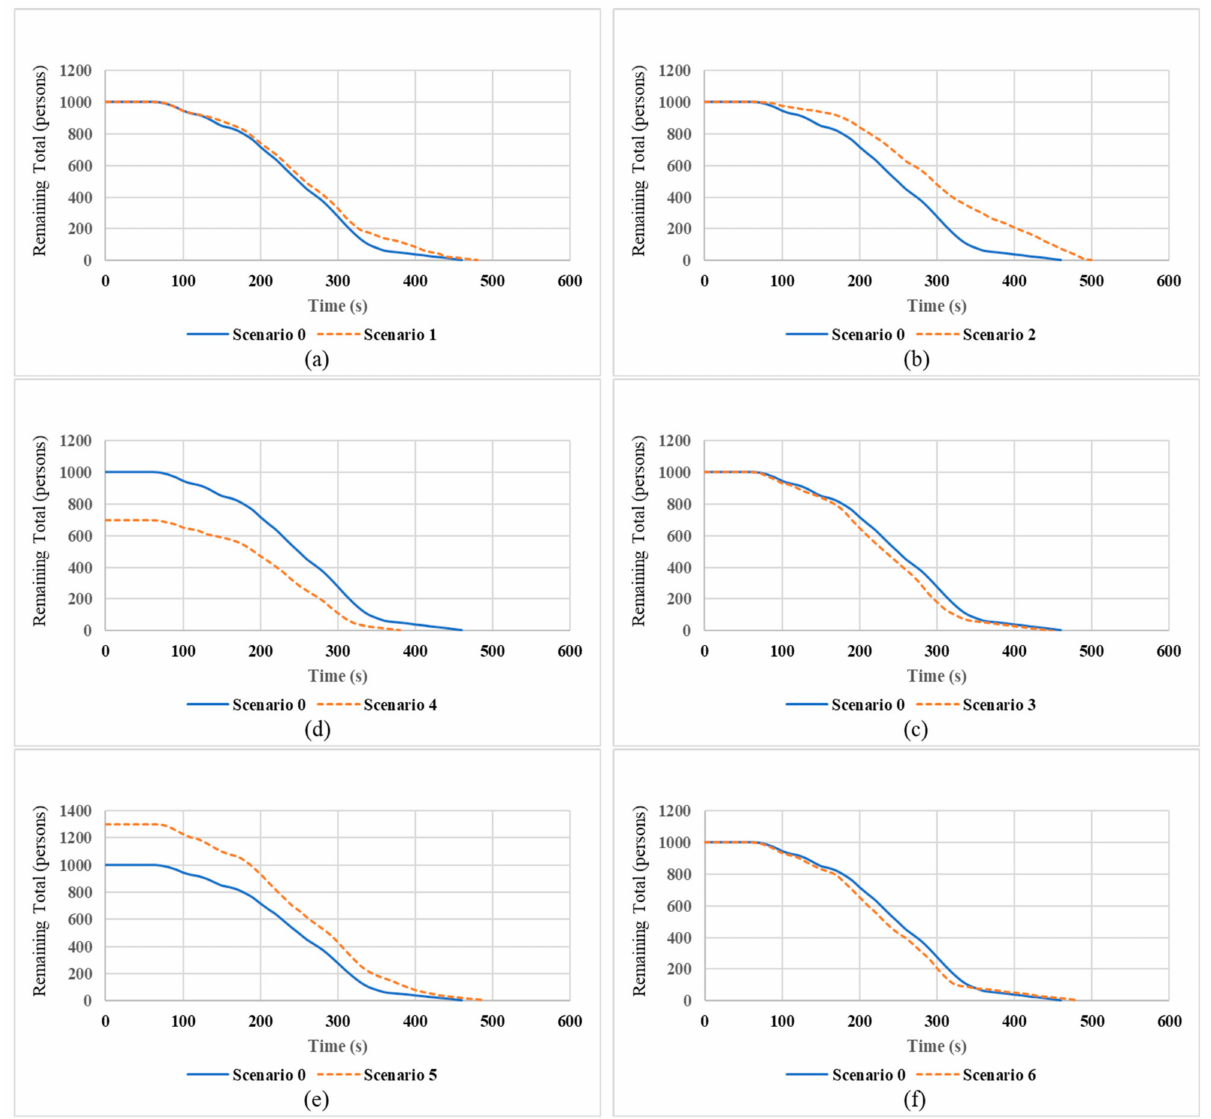
Figure 7. Remaining evacuees for experimental design. ( a ) scenario 0 vs. scenario 1; ( b ) scenario 0 vs. scenario 2; ( c ) scenario 0 vs. scenario 3; ( d ) scenario 0 vs. scenario 4; ( e ) scenario 0 vs. scenario 5; ( f ) scenario 0 vs. scenario